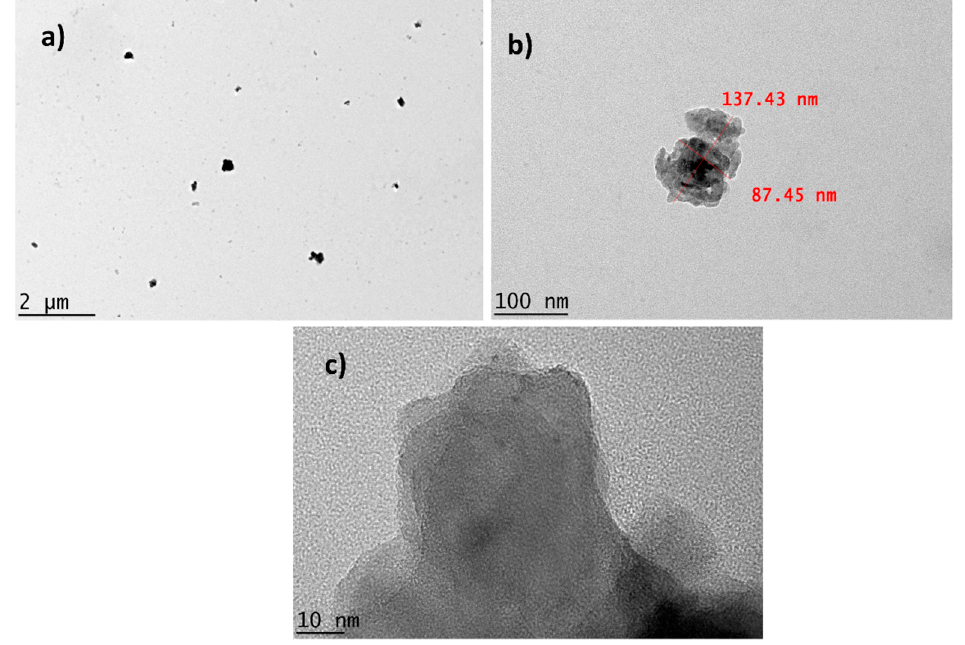
Figure 5. Images of dolomite nanoparticles (DNPs): ( a ) at low magnification, ( b ) at high magnification (with the measured length and width), and ( c ) platy/sheet-like particles of DNPs with a very small thickness (less than 100 nm).